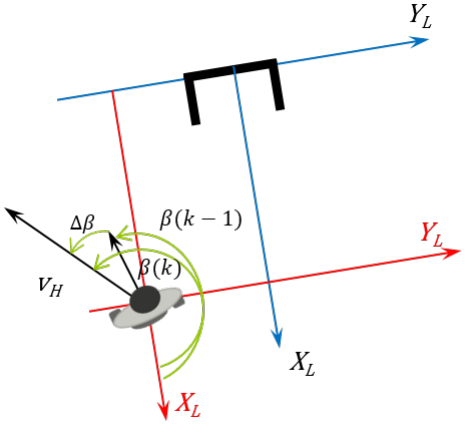
Figure 14. User angular speed by β -angle variation.